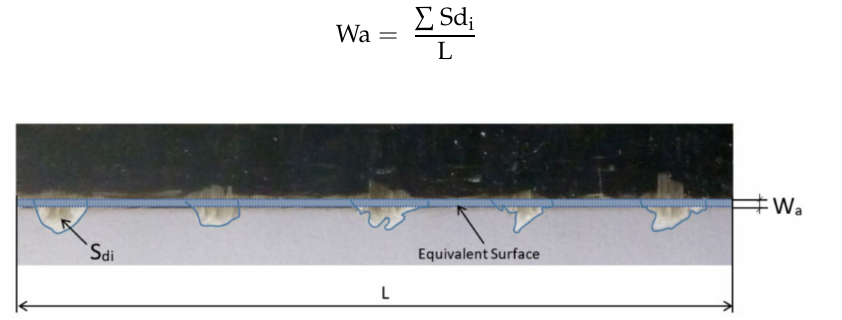
Figure 6. Medium delamination parameter (Wa) for Type II